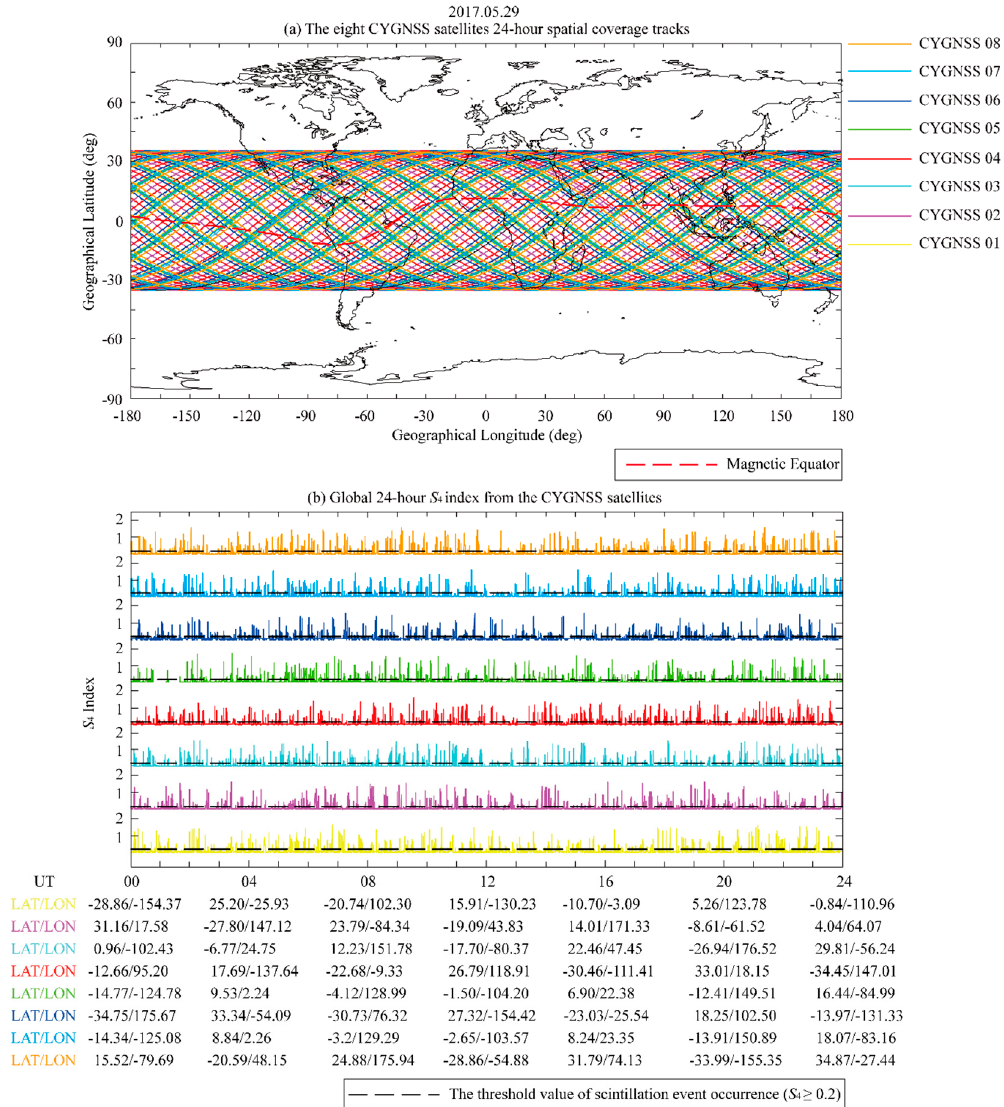
Figure 1. Example of observations taken by the CYGNSS satellites on May 29, 2017. ( a ) The eight CYGNSS satellites 24-hour spatial coverage tracks. ( b ) Global 24-hour S 4 index from the CYGNSS satellites. The magnetic equator is represented by red dotted line. The black dotted line indicates the threshold value of scintillation event occurrence ( S 4 ≥ 0.2).